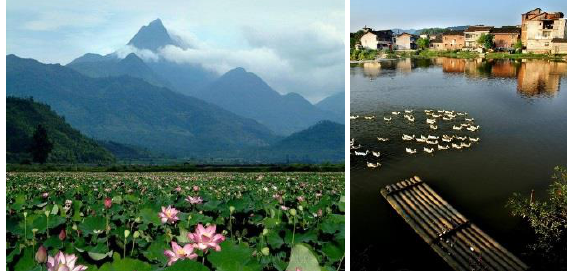
Figure4. Farmland And Vegetable Field (Picture source:download from www.baidu.com)